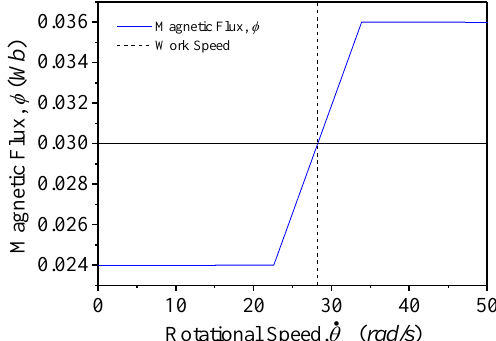
Figure 9. Magnetic flux variation for the generator.